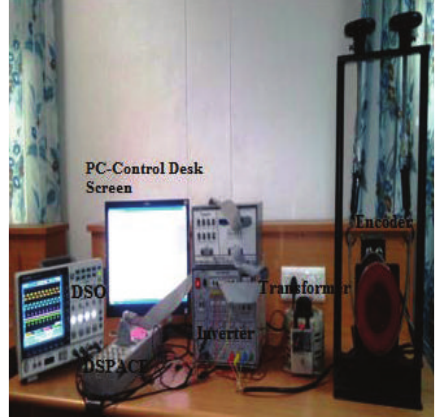
Figure 12: Hardware setup of control actuation system.